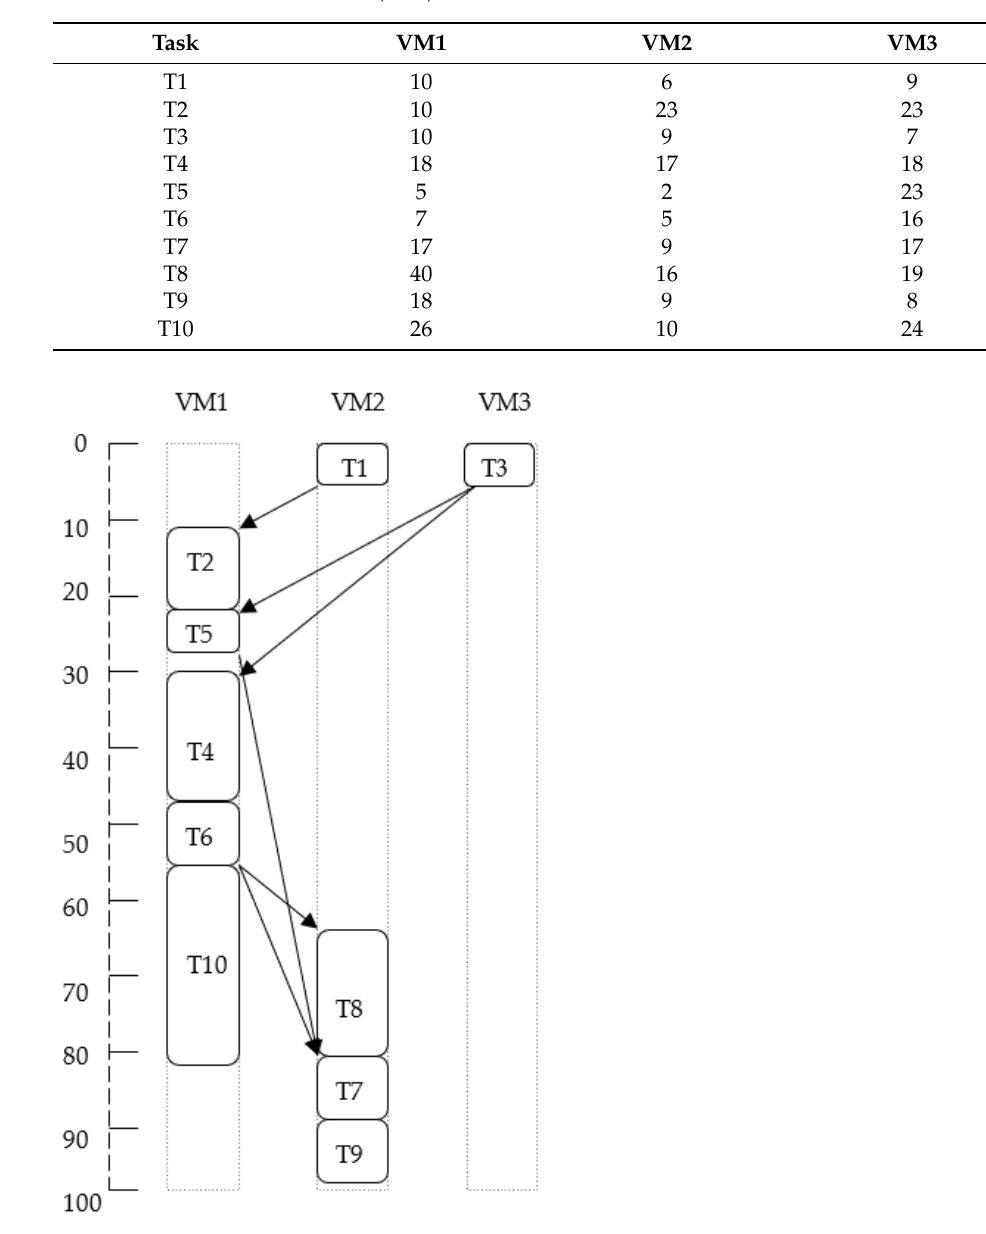
Figure 5. Scheduling of DAG with modified HEFT algorithm (use of maximum computation cost in rank calculation). The schedule length is 96.